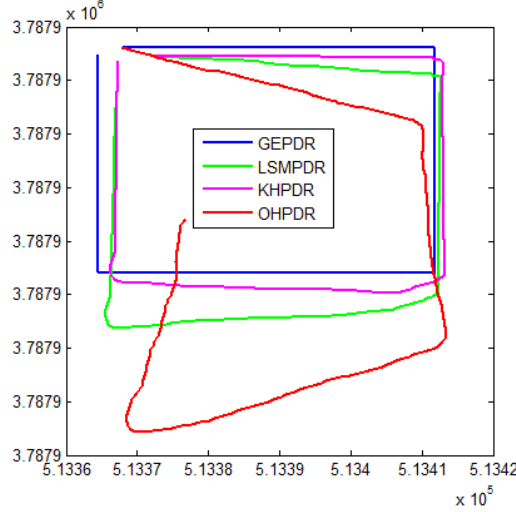
Figure 13. Analysis on positioning trajectory (rectangular corridor on the 3rd floor) for four methods Standard deviation of the positioning error and root mean square deviation of the positioning results were recorded for three groups of experiments. Table 3. Positioning analysis for different solutions associated with PDR in rectangular corridor on the 3rd floor.